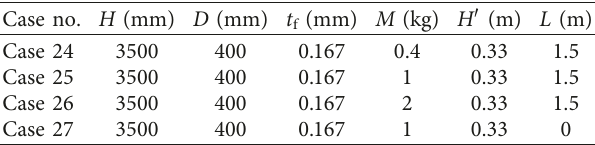
Figure 7: Displacement-time history curve of the midspan of SC-2. Table 8: Four different cases of specimen